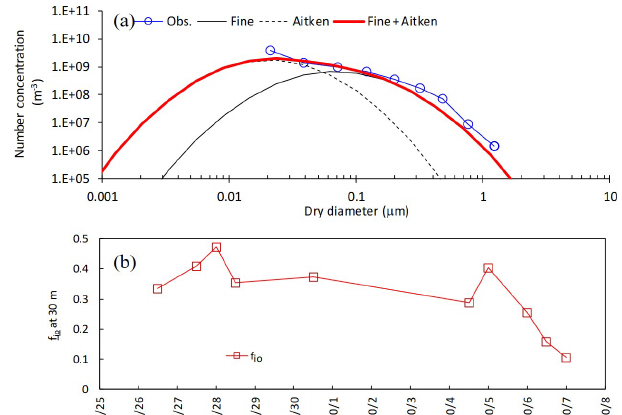
Figure 1. (a) Modeled and observed number-based size distribution of particles at 10:00 on 7 November 2016. (b) Temporal changes in the volume fraction of inorganic compounds ( f io ) for the early- autumn period. Please note that the date is given on the x axis in the month/day